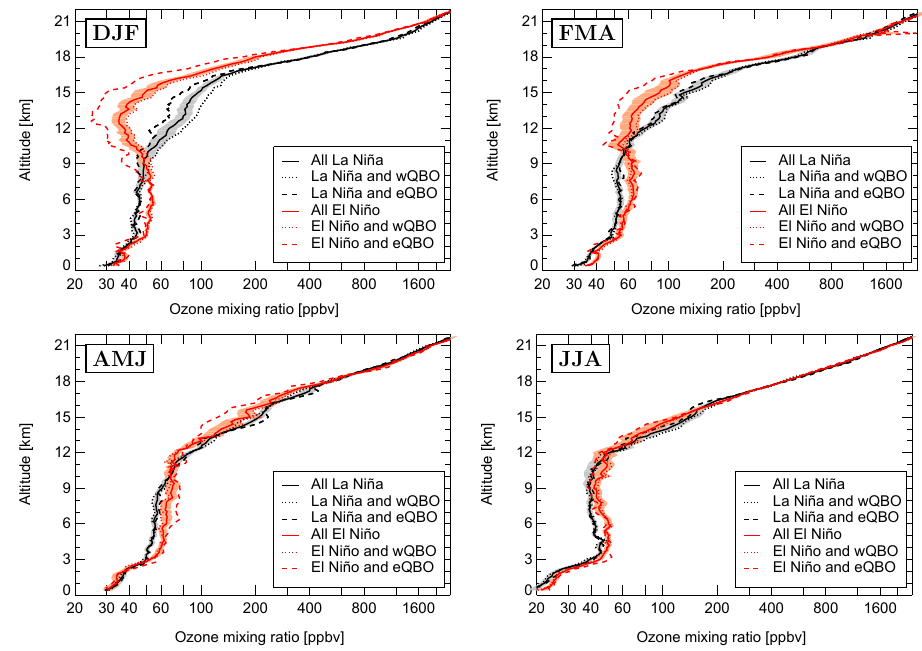
Figure 11. Composites of the ozonesonde measurements from SHADOZ in Hilo, Hawaii 19.43 ◦ N, 155.04 ◦ W during 1998–2015. Black and red lines represent the seasonal mean profiles for La Niña and El Niño composites. The shading indicates the standard deviation of the mean. The dotted and dashed lines represent the results for subcomposites defined by the westerly and easterly phases of the